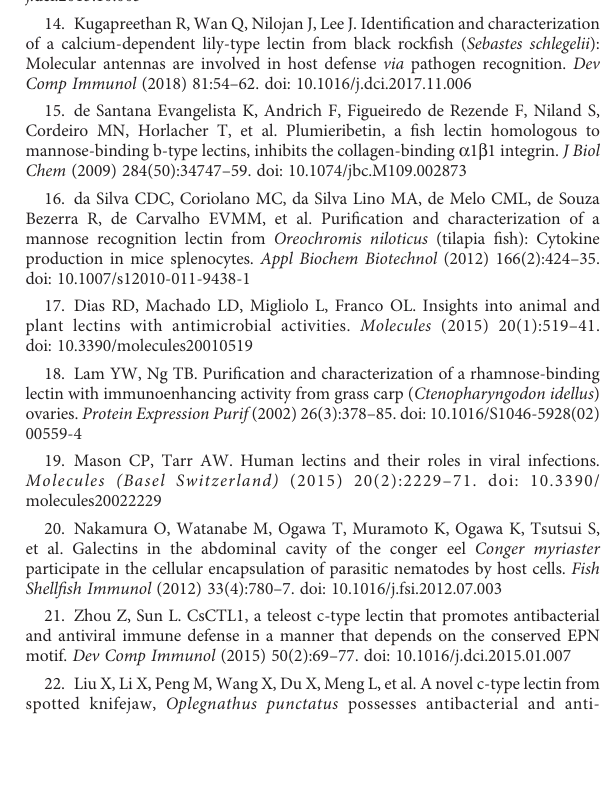
SUPPLEMENTARY FIGURE 1 Multiple alignment of B-lectin domain sequences from OppLTL and other fi shes. The three conserved D-mannose binding sites are marked with blue boxes. The accession numbers are as follows: Oplegnathus fasciatus (ADV35591.1, ADV35592.1, and ADV35593.1), Sebastes schlegelii (ATS17370.1), Larimichthys crocea (ADN97105.1), Nuchequula nuchalis (BAE79275.1), Platycephalus indicus (BAE79274.1), Epinephelus coioides (AEG78370.1), Channa striata (CCQ25776.1 and CCQ48558.1), and Scophthalmus maximus (ANB44750.1).